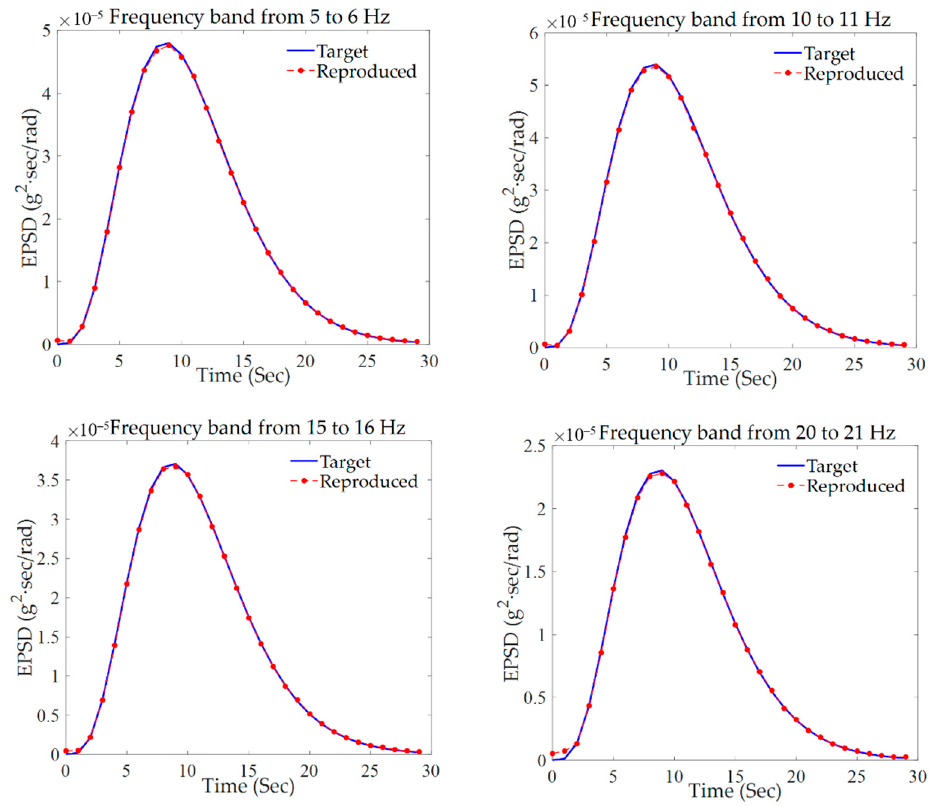
Figure 12. Comparations between the target and reproduced EPSDs at different time instants.